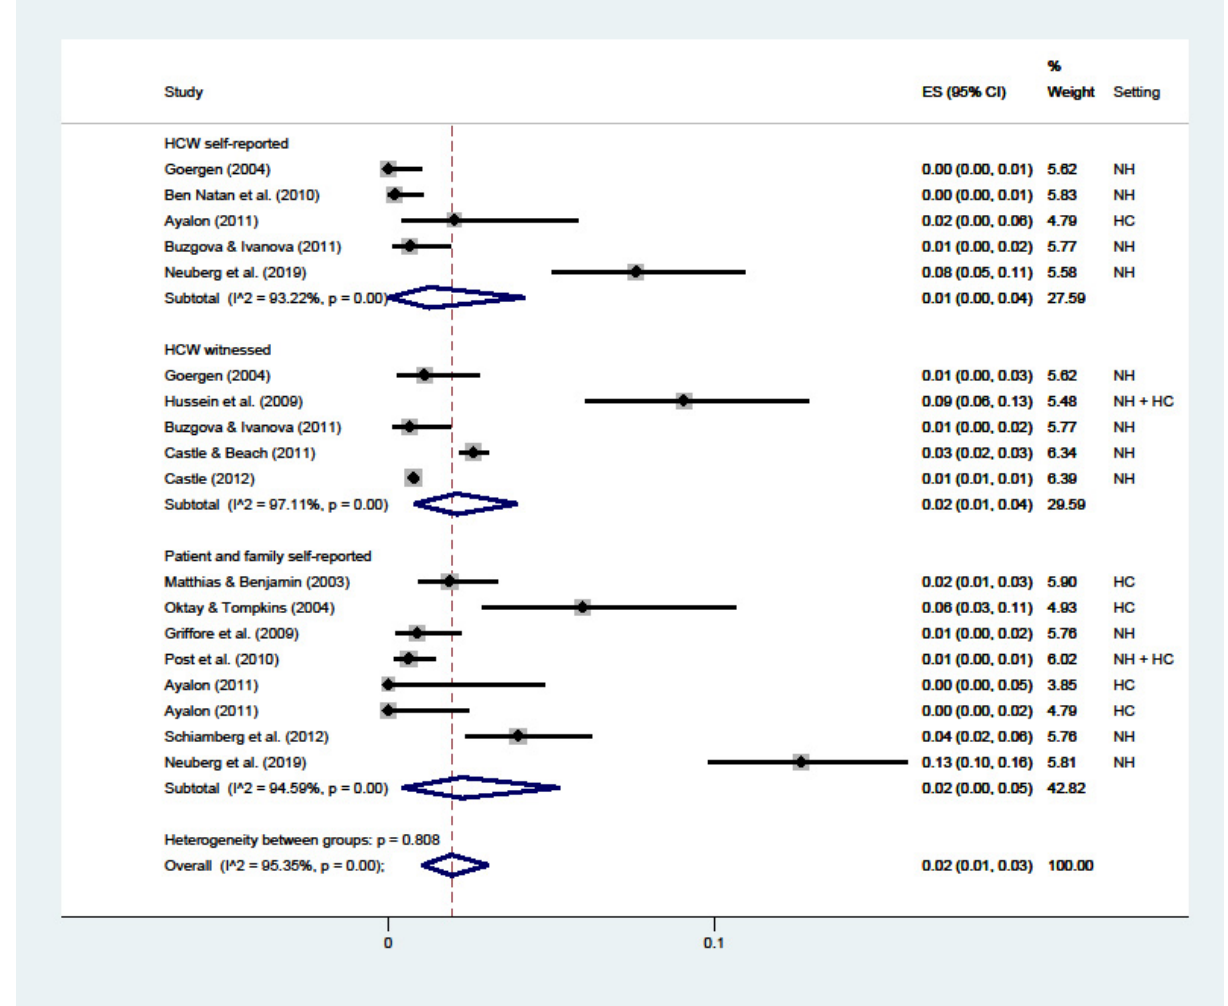
Figure 6. Forest plot of the prevalence of sexual abuse in LTC. Subgroup meta-analyses by (Healthcare workers (HCW) self-reported, HCW witnessed, or patient and family self-reported). NH: nursing home; HC: home care.